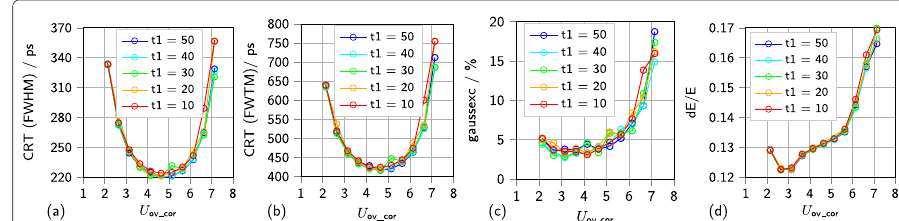
Fig. 6 Impact of the trigger threshold on CRT and energy resolution. Measurements were conducted with two Hamamatsu S14161-3050-HS-08 each coupled to an 8 × 8 12-mm-high LYSO scintillator array featuring 360 μ m BaSO 4 powder mixed with epoxy as segmentation layer. Single scintillator needles had a size of 3 mm × 3 mm × 12 mm. A geometry of five NEMA cubes ( 22 Na sources) with a total activity